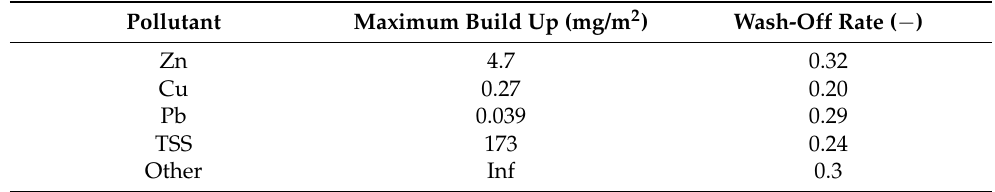
Table A5. Maximum build-up values and wash-off rates for different pollutants, taken from refer- ence